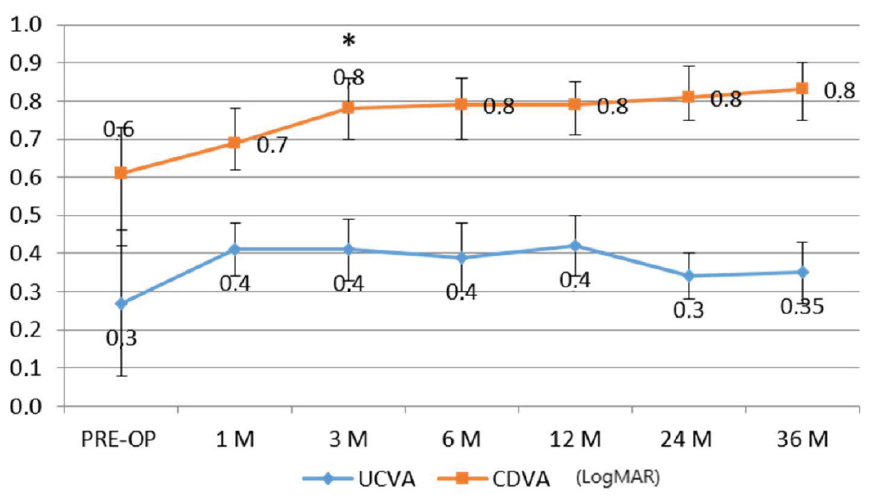
Figure 1. The uncorrected distance visual acuity (UDVA) did not show statistically significant changes, while the spectacles corrected distance visual acuity (CDVA) showed an improvement, becoming statistically significant at the third postoperative month ( ∆ + 0.2 ± 0.08 decimal equivalents). The apical curvature (AK) flattened significantly, becoming statistically significant